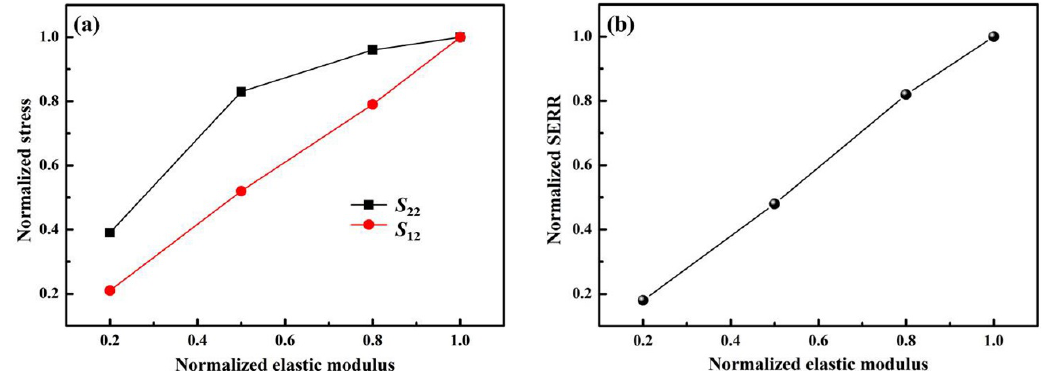
Fig. 33 Effects of sintering on stress and SERR at the crack tip: (a) stress and (b) SERR. Reproduced with permission from Ref. [167], © Elsevier Ltd and Techna Group S.r.l. 2019.